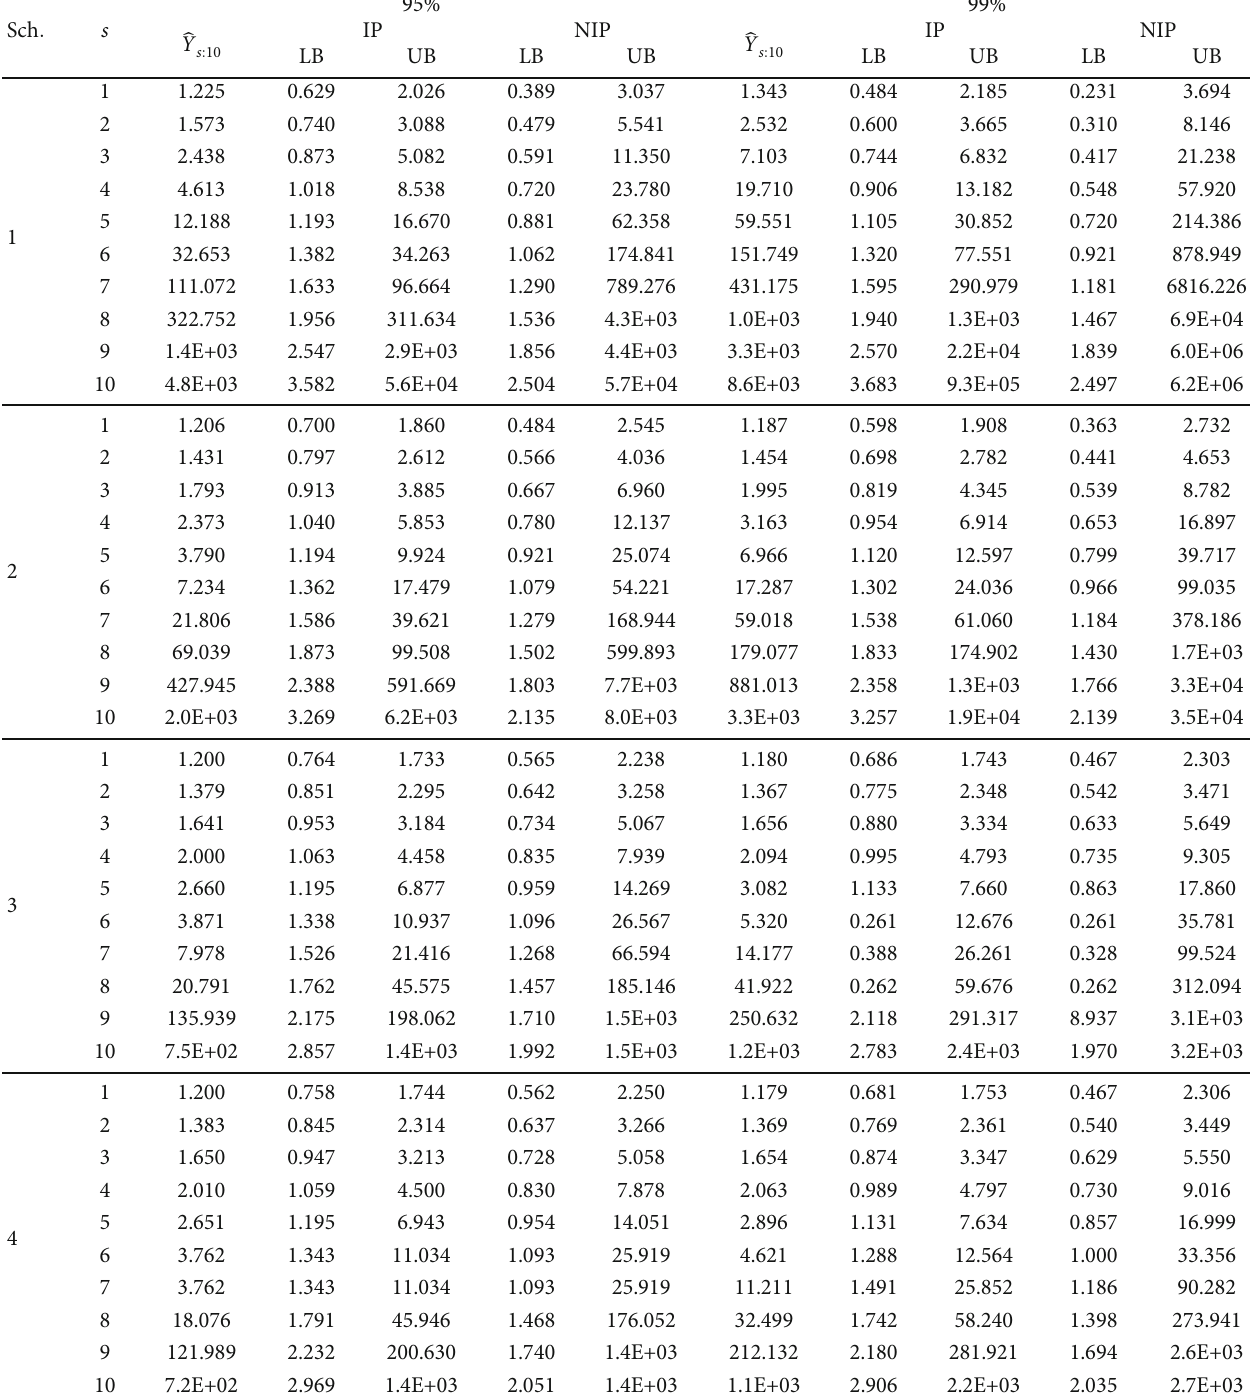
Table 12: Bayesian point predictor with 95 % and 99 % ET prediction intervals for Y